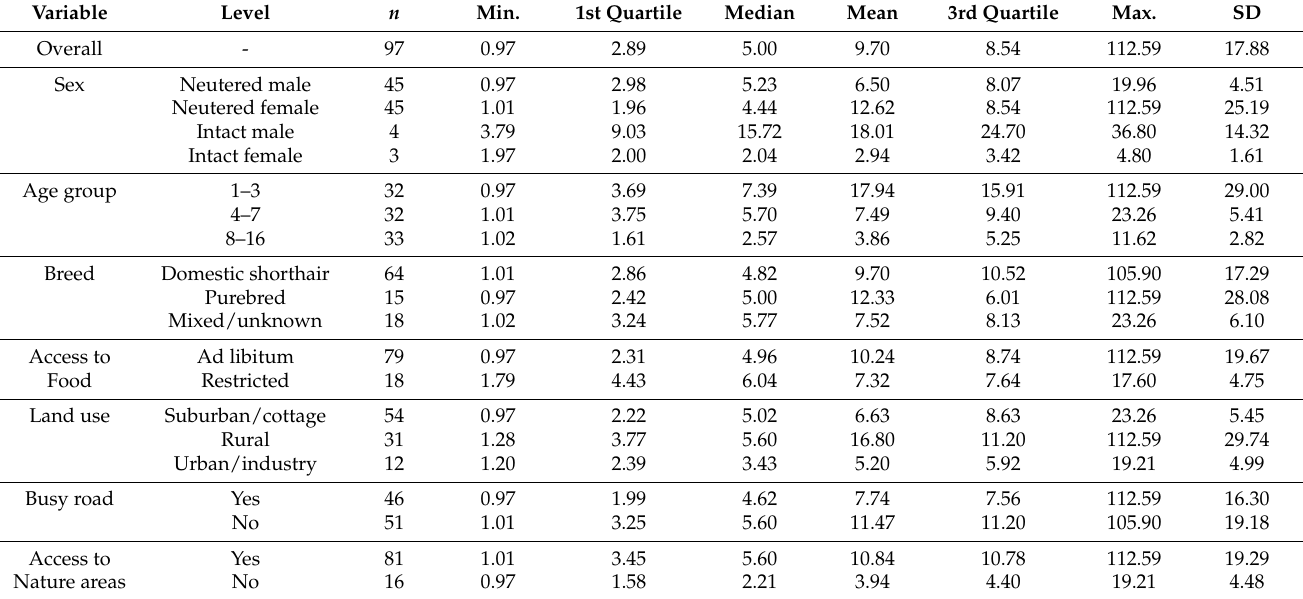
Table 4. Summary of sample sizes ( n ) and descriptive statistics for 95% BBKDE home range estimates stratified by the explanatory variables. SD = Standard